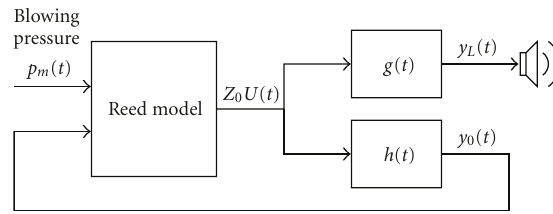
Figure 2: A convolutional synthesis approach to the signal flow diagram shown in Figure 1, with signals h ( t ) and g ( t ) being the impulse responses of the instrument tapped at the positions y 0 ( t ) and y L ( t ), the inverse transforms of (1) and (2), respectively. The input pressure is the product of the characteristic (wave) impedance Z 0 at the mouthpiece and the volume flow U ( t ), a signal generated by a reed model in response to a blowing pressure p m ( t